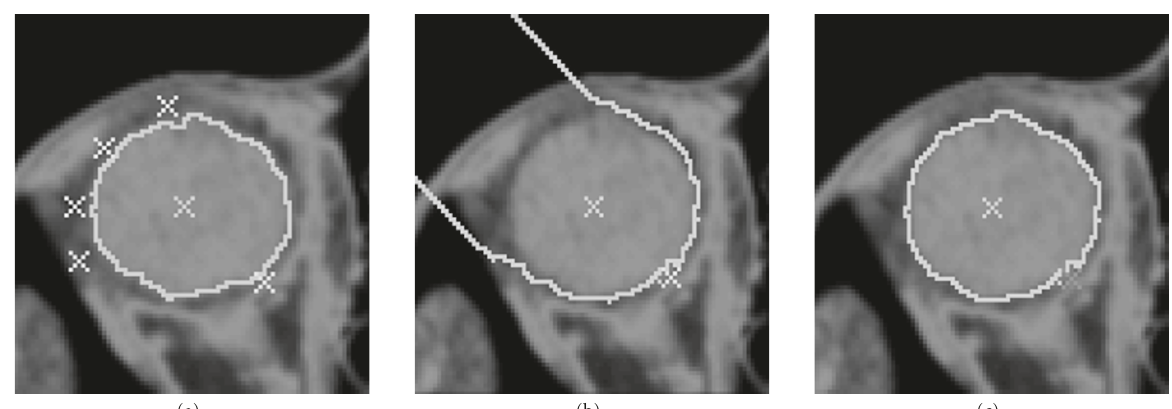
Figure 5: A CT image of the orbital region where the eye ball is obtained by seed competition. (a) One internal seed and many external seeds are required for segmentation, using f max with δ 4 . (b) The segmentation fails when some of the external seeds are removed. (c) A value of κ is used to limit the influence zone of the internal seed in parts, where the seed competition